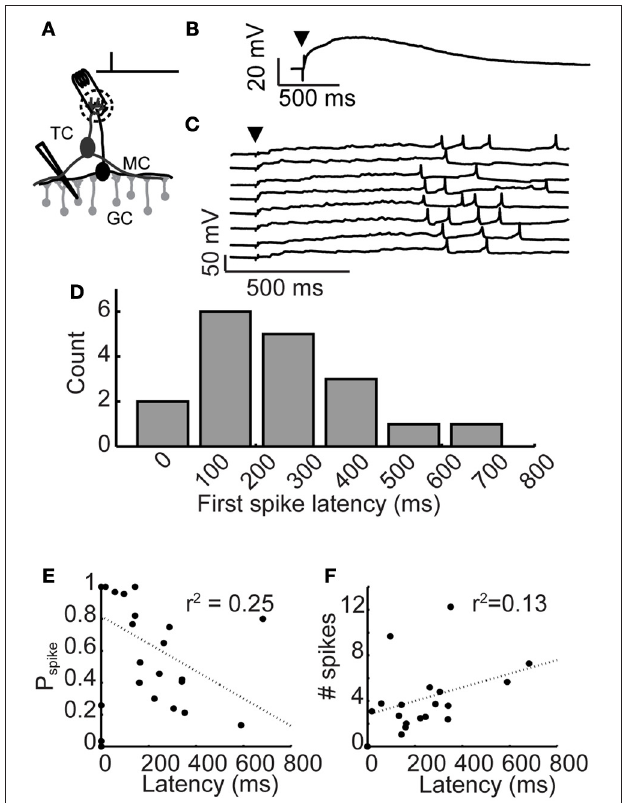
FIGURE 1 | Long-latency granule cell activity. (A) Experimental setup: A brief, 300 μ s stimulation pulse was applied via an extracellular stimulating electrode impaled into a glomerulus. Responses of inhibitory granule cells were recorded using patch clamp. (B) Average depolarization following glomerular stimulation. Arrowhead denotes stimulation time. (C) Example voltage traces from a granule cell following glomerular stimulation (arrowhead), eight trials shown. (D) Distribution of mean first spike latencies across granule cell population. (E) Relationship between granule cell first spike latency and spike probability. (F) Relationship between granule cell first spike latency and evoked